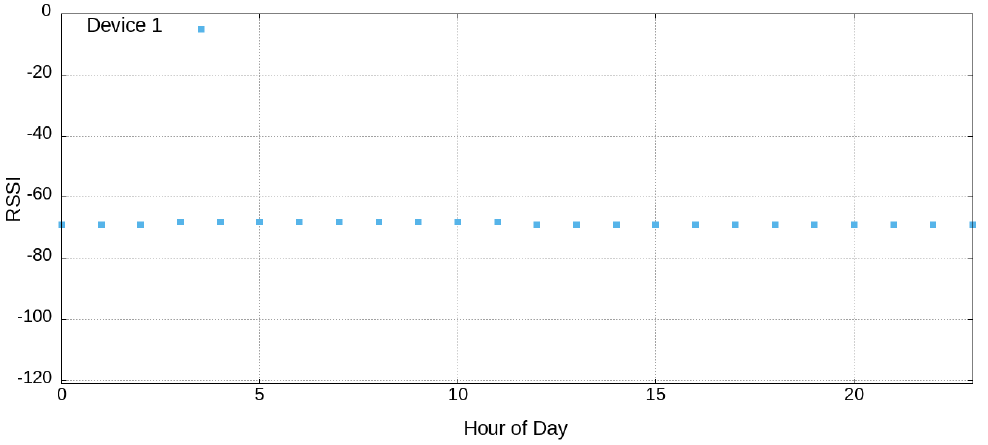
Figure 9. wM-Bus RSSI variability during a